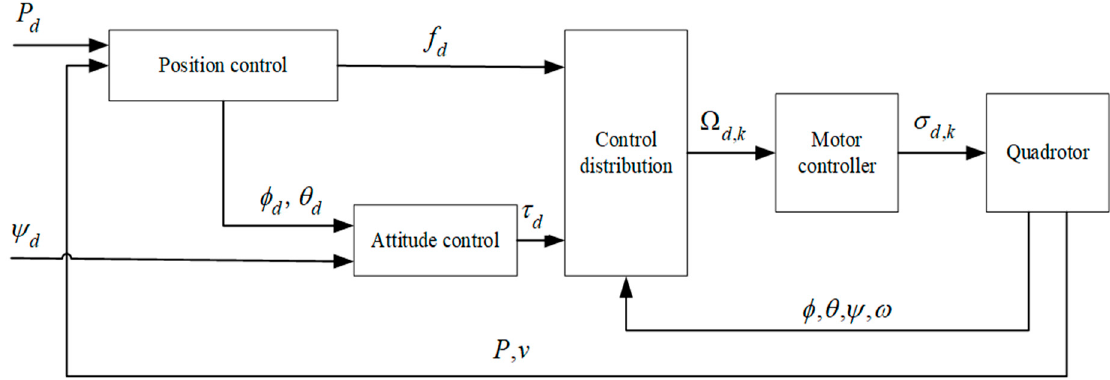
Figure 4. Closed loop block diagram of the autonomous control of the quadrotor. As the height control of the quadrotor has nothing to do with the attitude of the body, there is an independent feedback input z in the height control system and the height correction is output after the height PID controller. Due to the balance between gravity and lift when the quadrotor is hovering, it is necessary to add gravity compensation to the height controller. When there is no error in the height, the controller can still output a stable value to control the motor rotation to maintain the hovering state. The simulation structure of the height controller is shown in Figure 5.